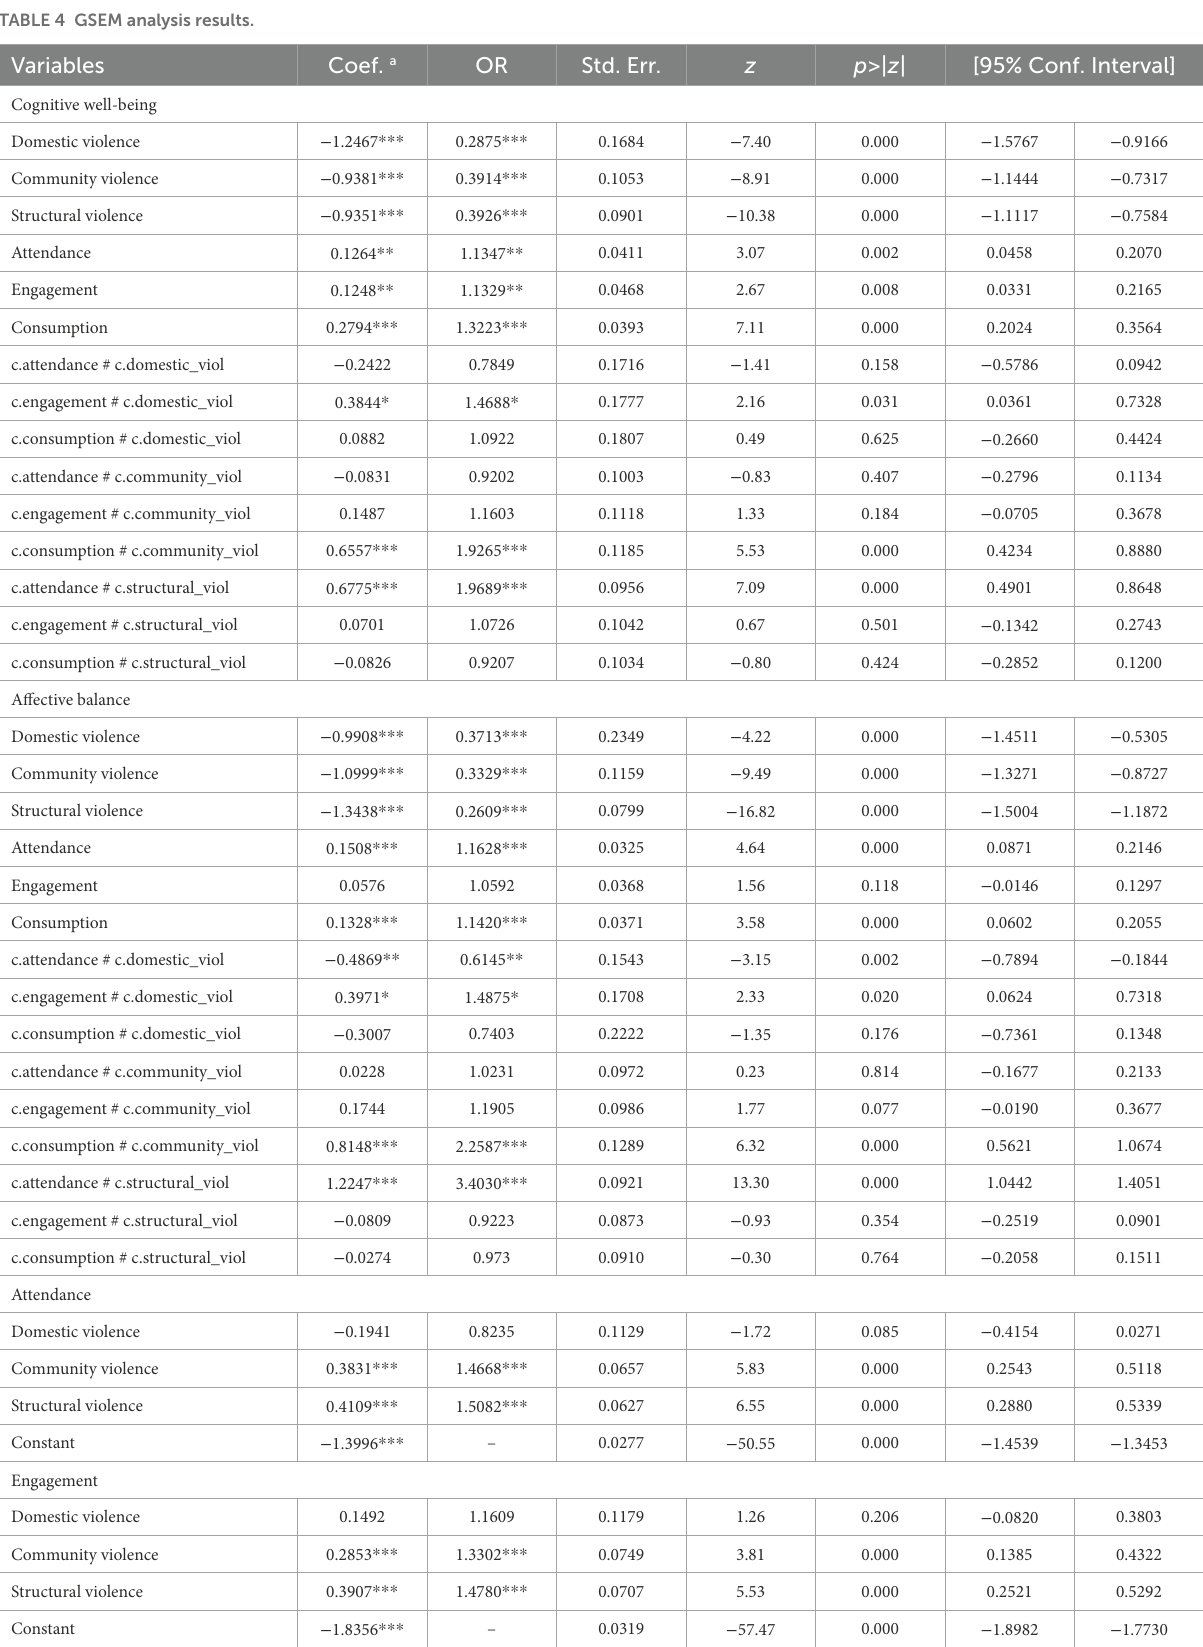
TABLE 4 GSEM analysis